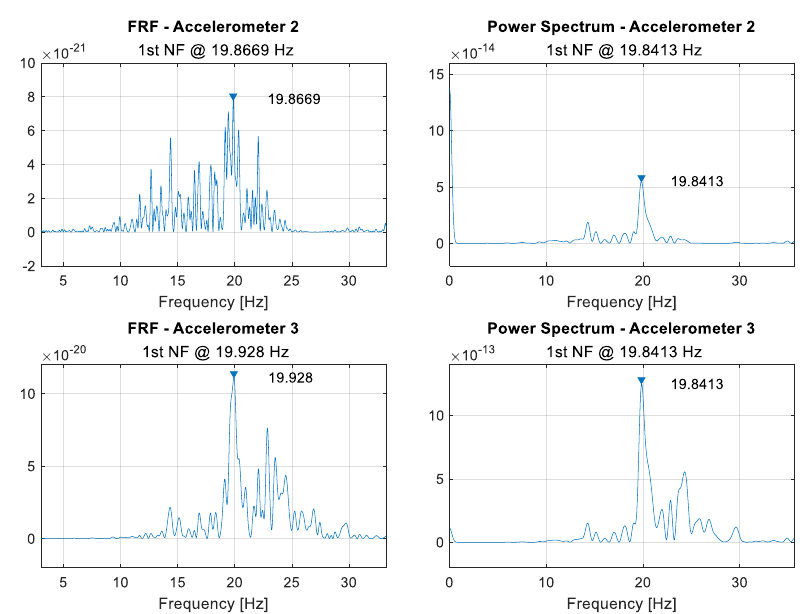
Figure A1. Close-up around first natural frequency, oscilloscope measurement white noise input, FRF and power spectrum plots, accelerometers 2 and 3.